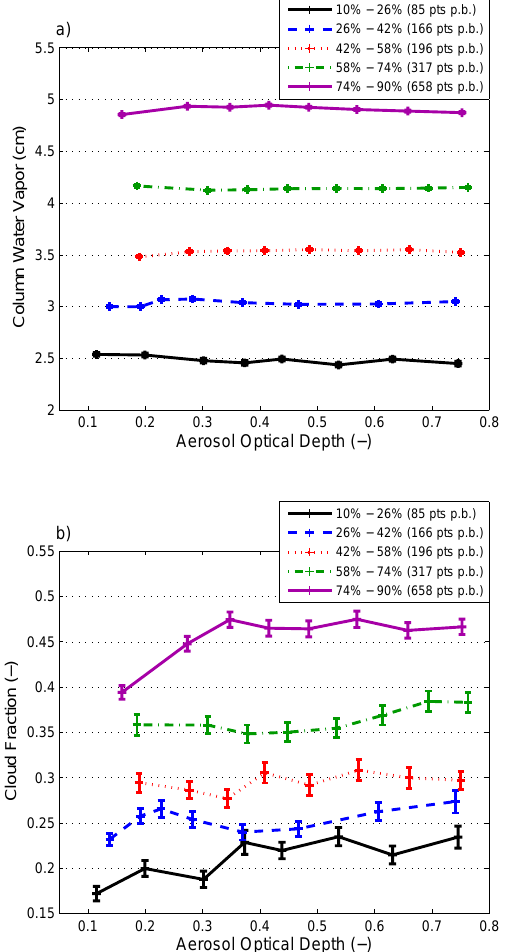
Fig. 5. (a) Column water vapor and (b) cloud fraction binned by aerosol optical depth for all co-located warm cloud retrievals, strat- ified by different percentile groupings of column water vapor. Data represent the months of August through October, for the years 2004 through 2007. The number of retrievals included each bin is noted in the legend.